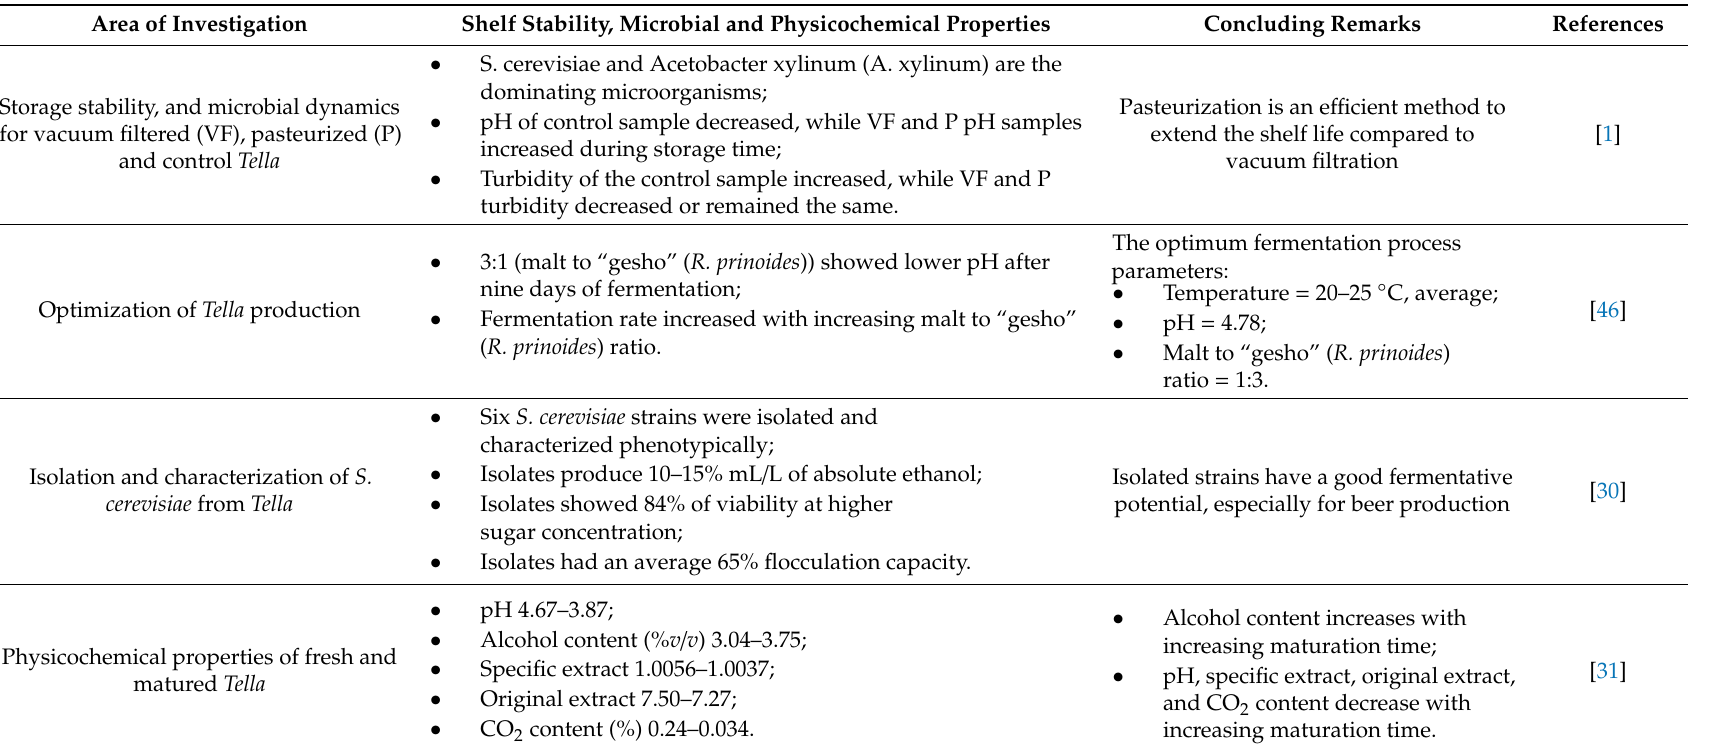
Table 2. Physicochemical properties, microbial load, and storage stability of